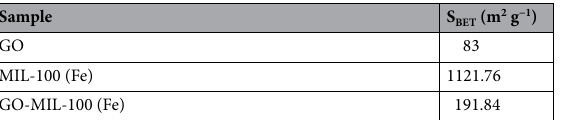
Table 1. Specific surface areas and micropore volumes of three studied species: GO, MIL-100(Fe), and GO-MIL-100(Fe).